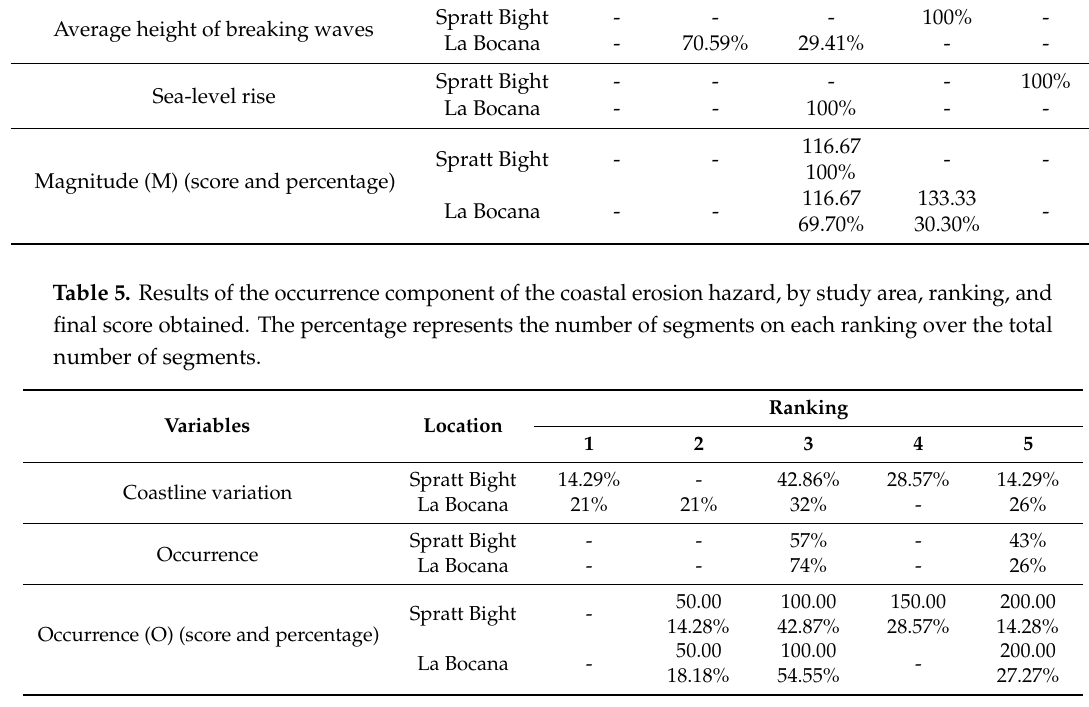
Magnitude (M) (score and percentage)